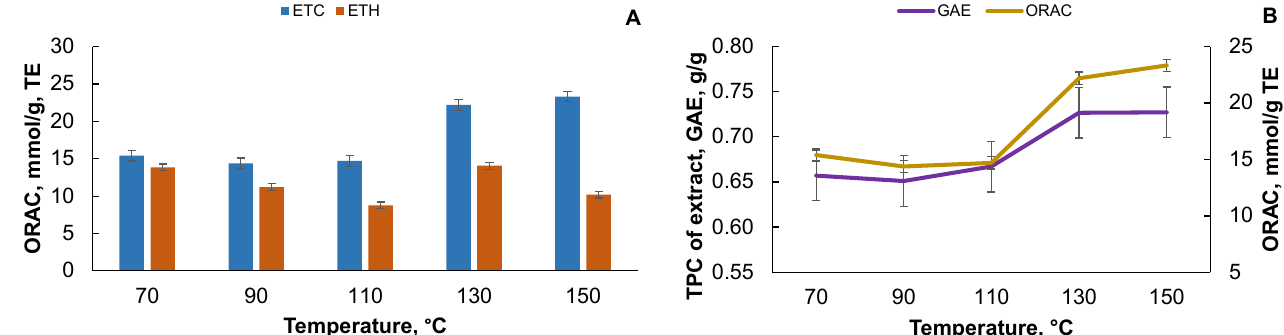
Figure 6. ( A ) Antioxidant activity (ORAC test) of the black alder bark ETC and ETH extracts and ( B ) the correlation between the antioxidant activity (ORAC test) of ETC extracts of black alder bark and total polyphenol (TPC) content. Data is shown as mean ( n = 4) values ± standard deviation. For ( A ) Kruskal–Wallis test, p < 0.05.